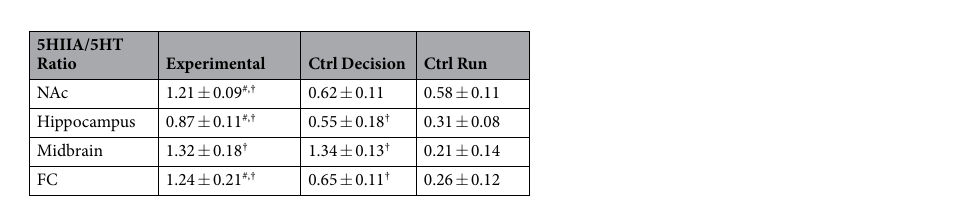
Table 2. 5-HIAA/5-HT ratio. Bonferroni’s post-hoc analysis significance: # p < 0.01 vs. CtrlDec; † p < 0.01 vs.